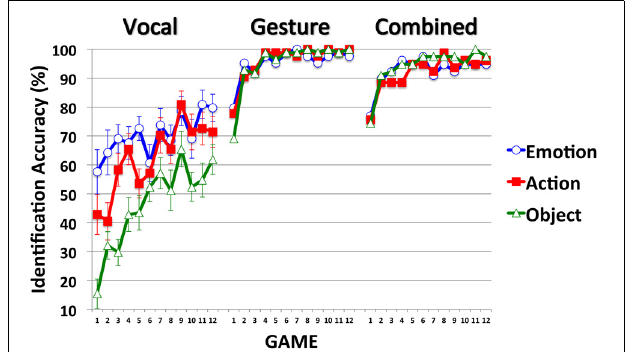
FIGURE 2 | Mean identification accuracy across Items (Emotion, Action, Object) and Games (1–12), expressed as percentage scores, for participants in the Vocal, Gesture, and Combined modalities. Error bars indicate the standard errors of the means (included only on items in the Vocal modality to reduce unnecessary